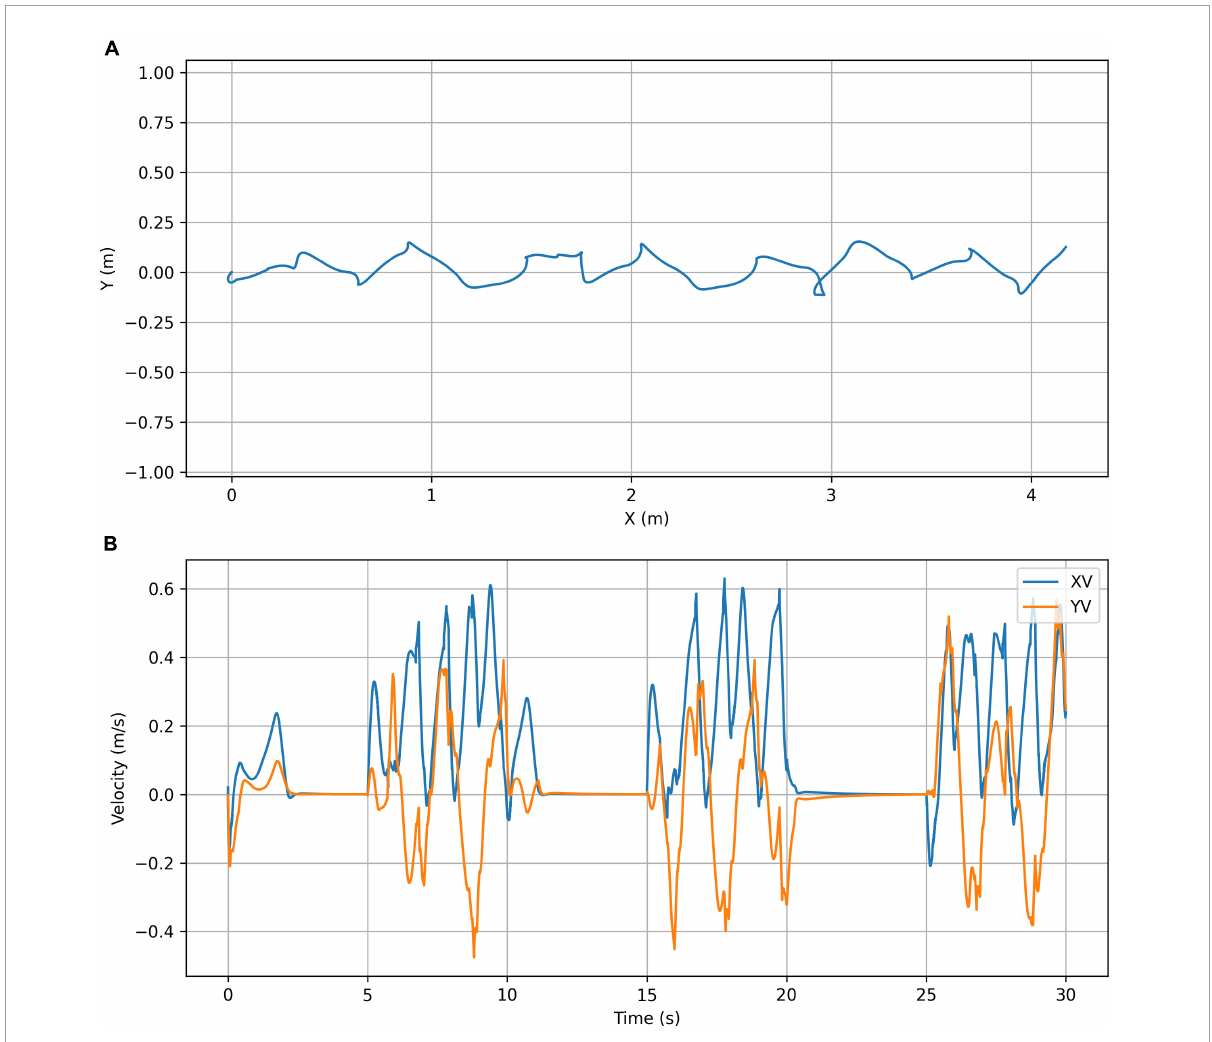
FIGURE3 Start-stop simulation plots. (A) Trajectory plot showing the top view of the path taken by the center of mass of the chimpanzee’s torso. (B) Velocity plot showing the X (forward) velocity and Y (lateral) velocity of the center of mass of the chimpanzee’s